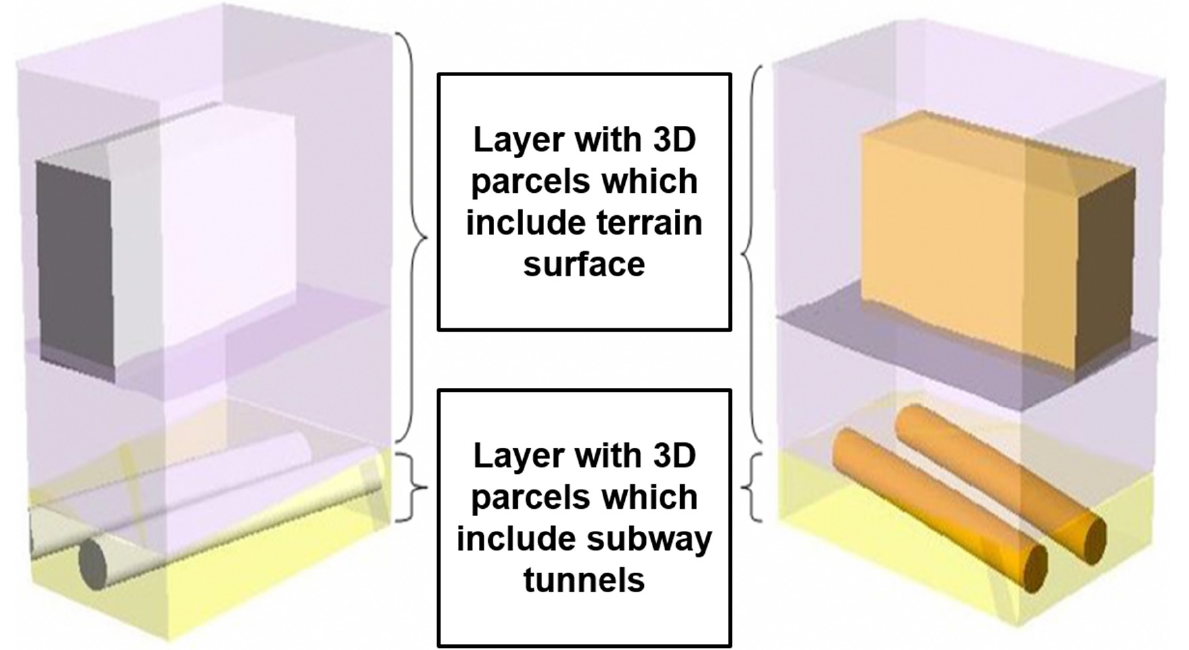
Figure 3. Visualization of subway tunnels as individual cadastral parcels. Based on [3].